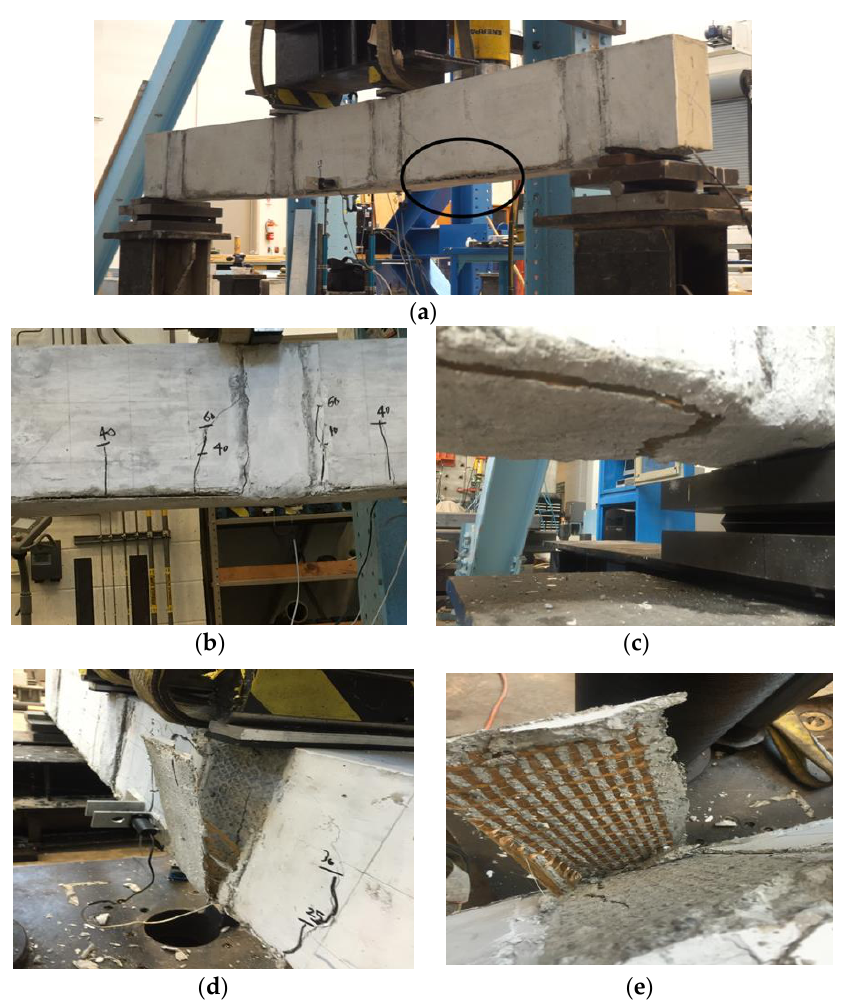
Figure 12. PBO FRCM-strengthened beam failure mode. ( a ) and ( b ): Detachment of PBO FRCM from concrete; ( c ): Cracking of the FRCM; ( d ) and ( e ): Detachment of FRCM u-wrap.